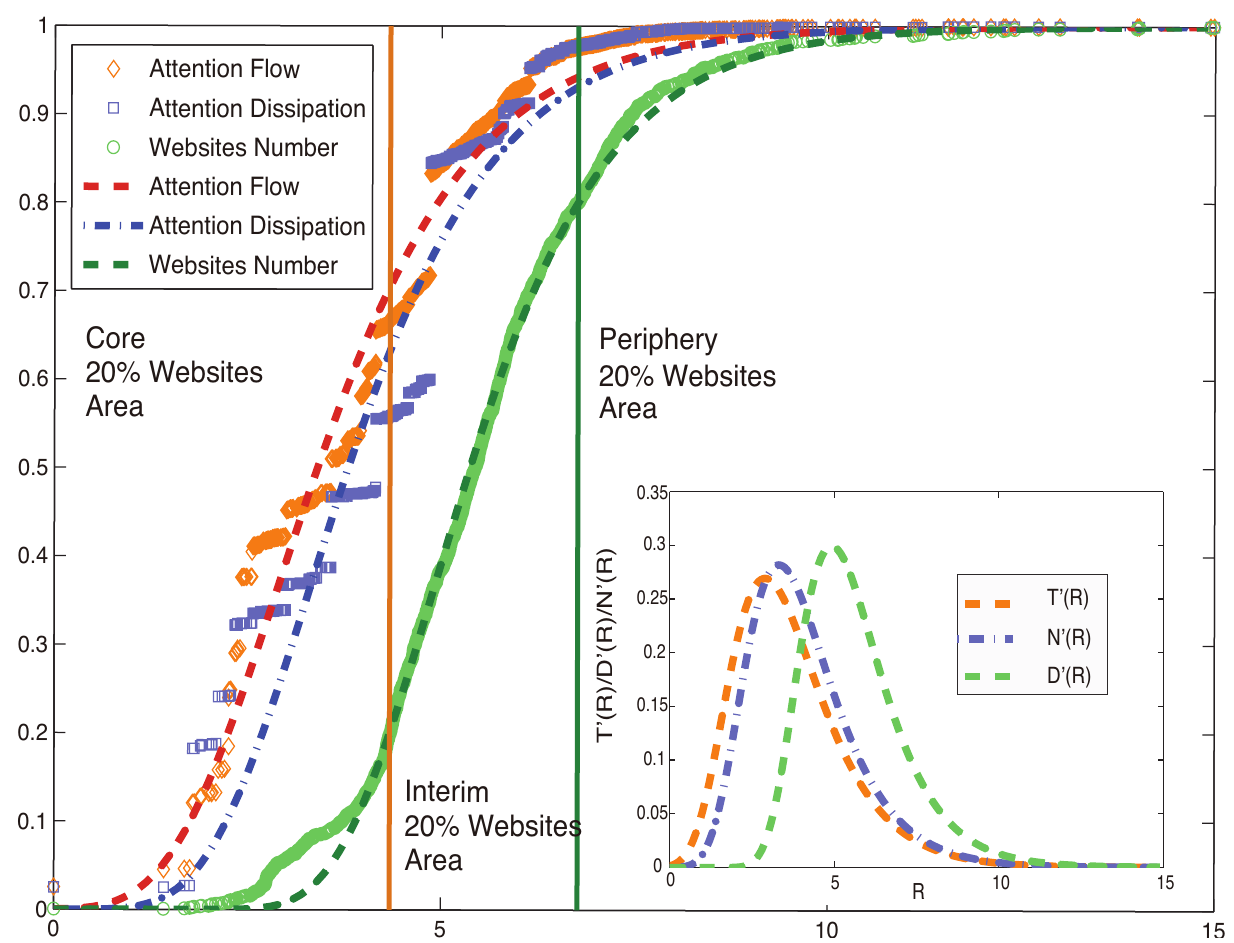
Fig 5. The normalized cumulative curves of attention flows (brown diamond), attention dissipations (blue squares), and the number of websites (green circles) along radius. The fitted normalized “ S ” curves for attention flows (dotted brown), dissipations (dashed and dotted blue), and the number of sites (dashed dark lines) are also shown. The inset shows the density curves of the three quantities and the derivatives to R of the three fitted “ S ” curves.